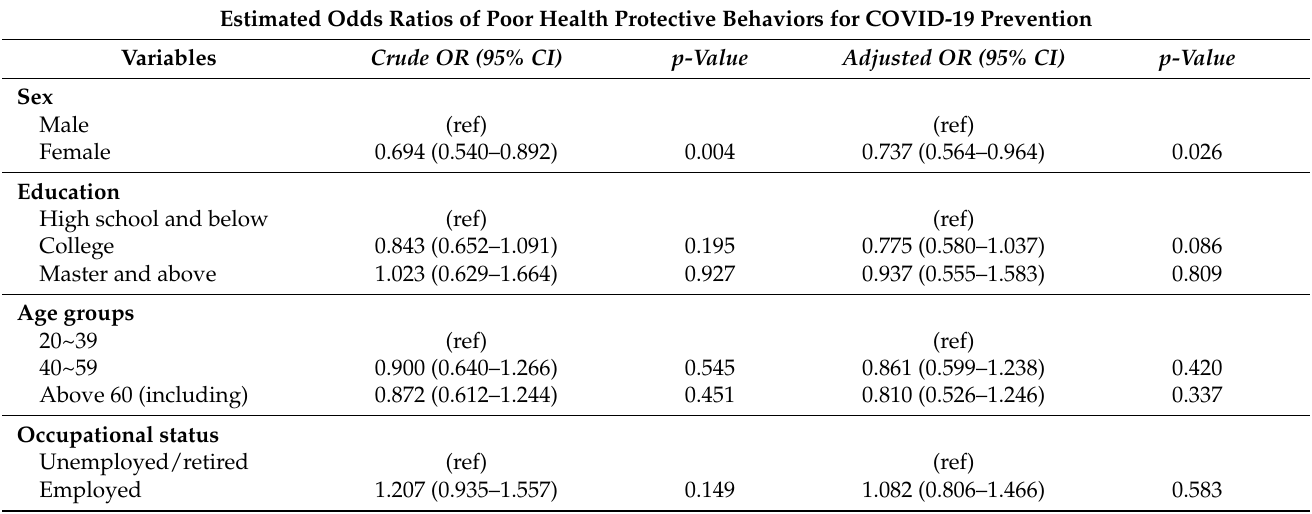
Table 4. Logistic regression model of poor health protective behaviors for COVID-19